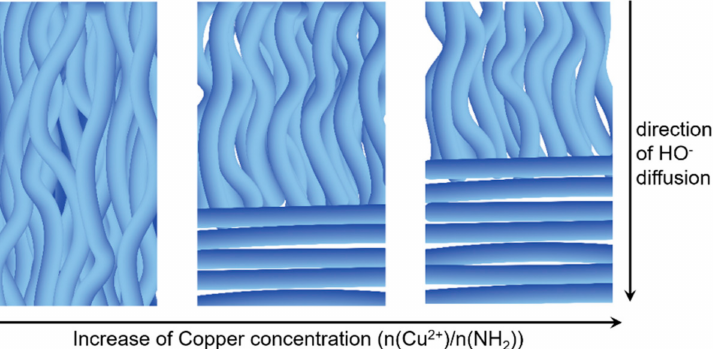
Figure 8. Illustration of Cu–CS hydrogel presenting multi-layered and oriented fibers structures depending on the concentration of Cu 2+